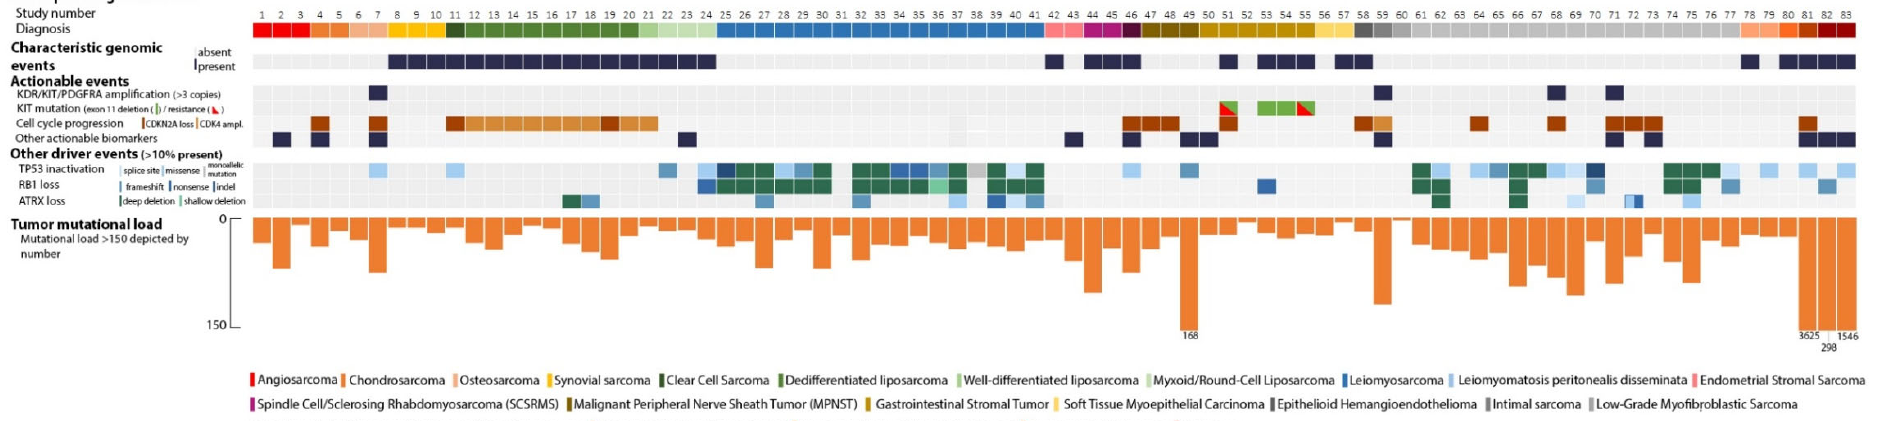
Figure 1. Oncoplot showing genomic information per sample.